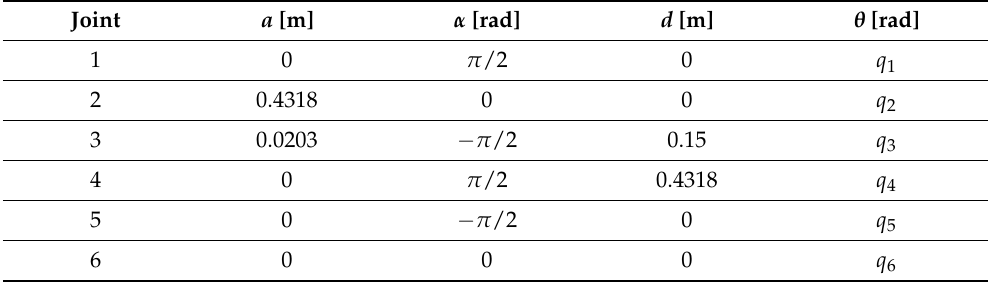
Table 2. DH table for KUKA Youbot